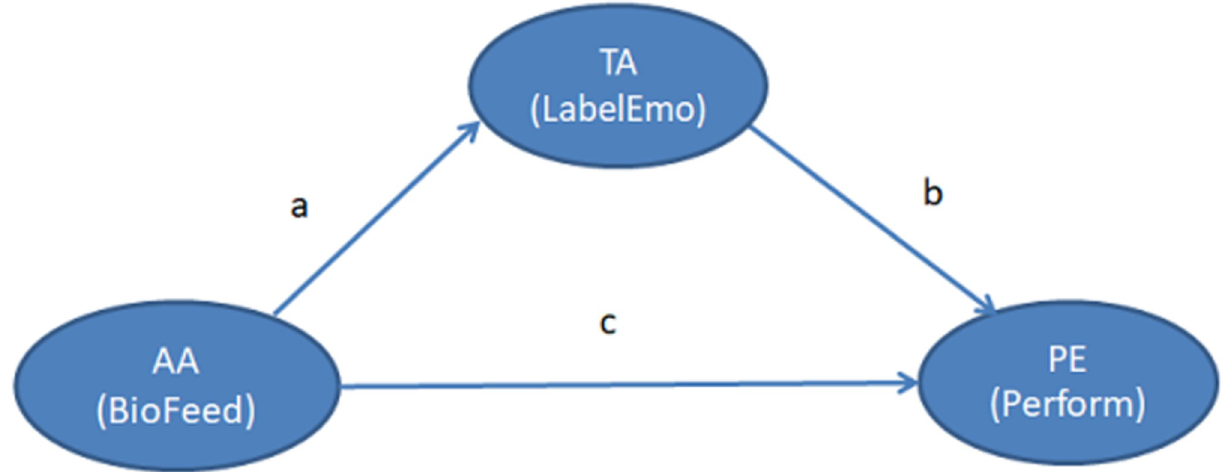
Fig 5. Test anxiety (TA) as an indirect effect between anxiety awareness as provided by biofeedback (AA) and performance (PE).